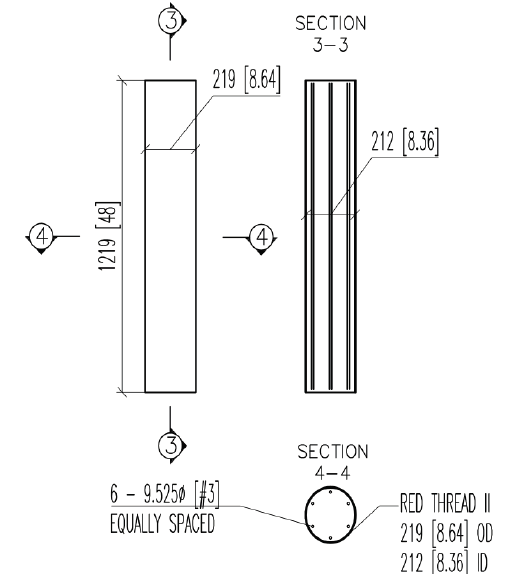
Figure 5. CFFT column design